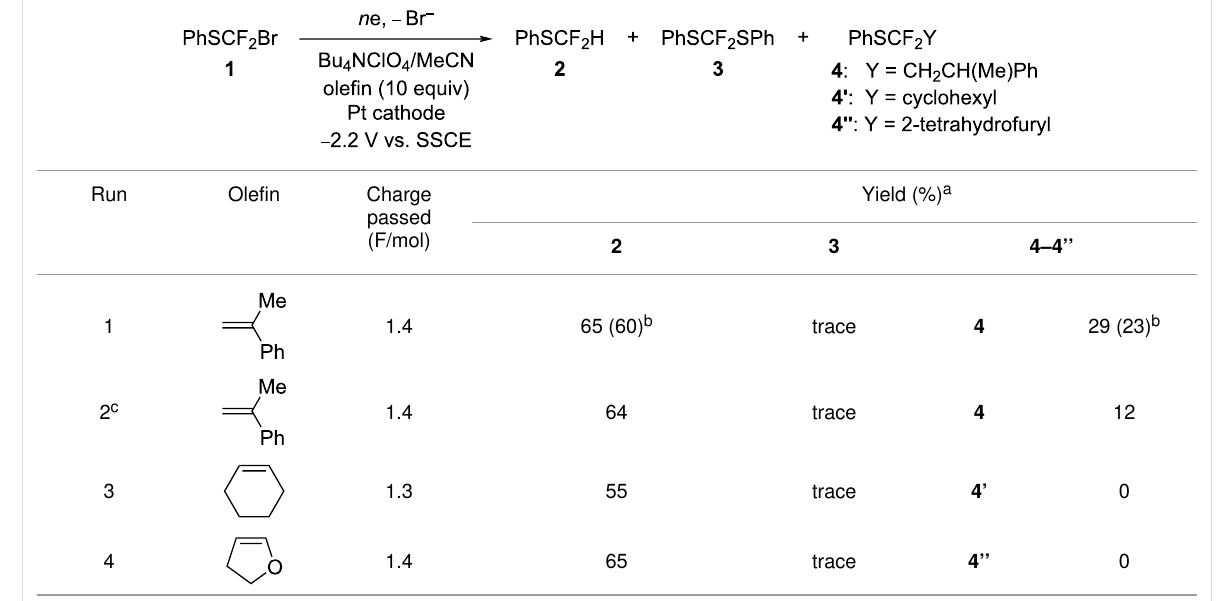
Table 1: Cathodic reduction of bromodifluoromethyl phenyl sulfide ( 1 ) in the presence of various olefins as a trapping reagent.